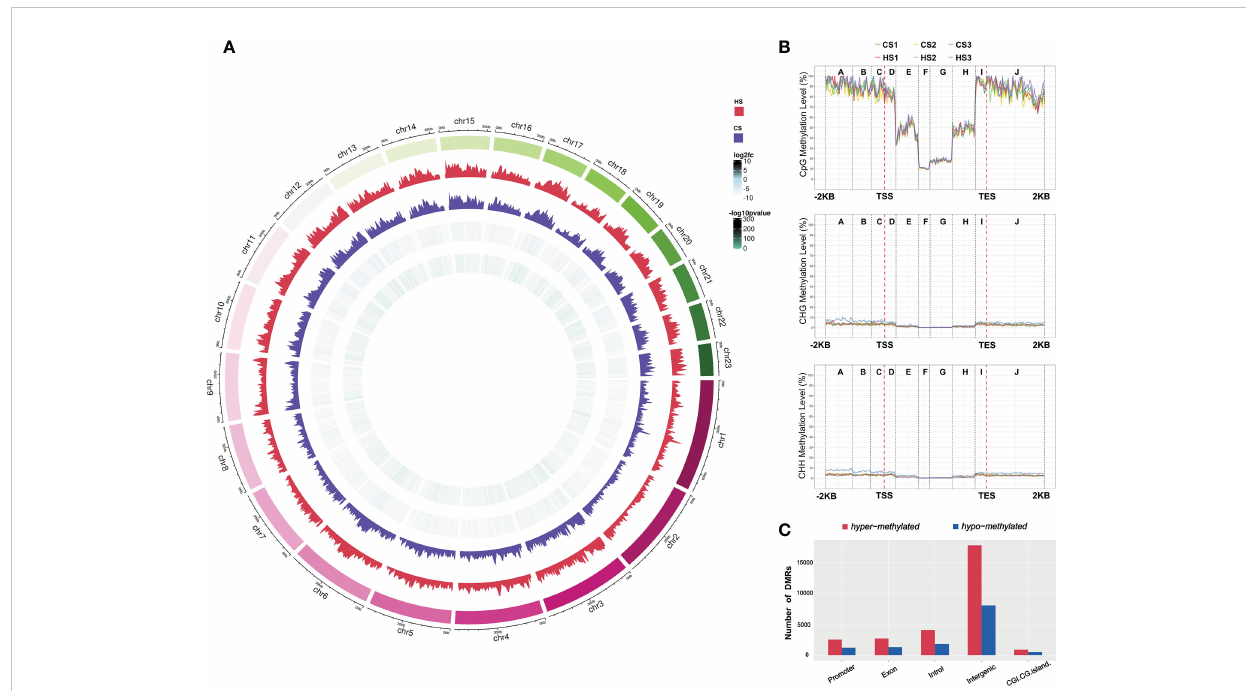
FIGURE 3 (A) Circos plot showing the distribution of DNA methylation differences at CG context between CS and HS groups across A. japonicus chromosome- scaled genome. The fi ve outer to inner circles represent chromosomes of A. japonicus , methylation levels of the HS group, methylation levels of the CS group, the fold change of methylation level between CS and HS groups, and the signi fi cance of methylation levels between CS and HS groups, respectively. (B) CHG, CHH and CpG methylation level distribution of different functional components. A: Distal promoter; (B): Intermediate promoter;